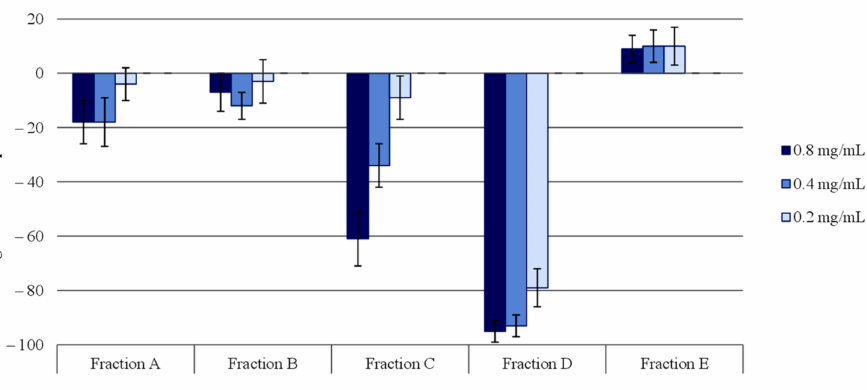
Figure 2. The bioactivities obtained in the etiolated wheat coleoptile bioassay for the fractions obtained from the acetone extract of Moquiniastrum pulchrum leaves. Values are expressed as the percentage difference with respect to the control. Each bar is the mean ± standard deviation.